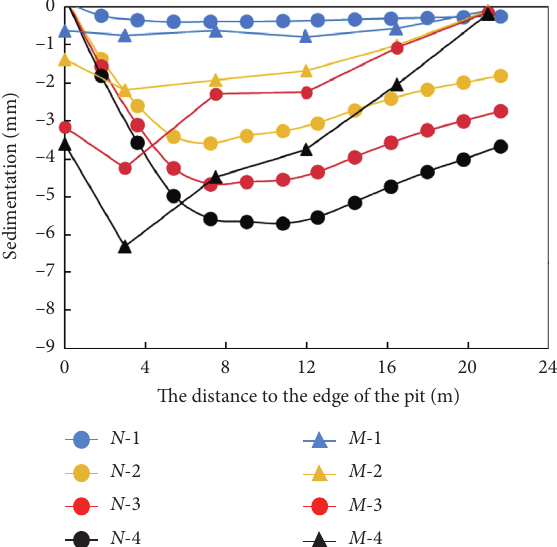
Figure 10: Soil settlement Contras of 0.40H.